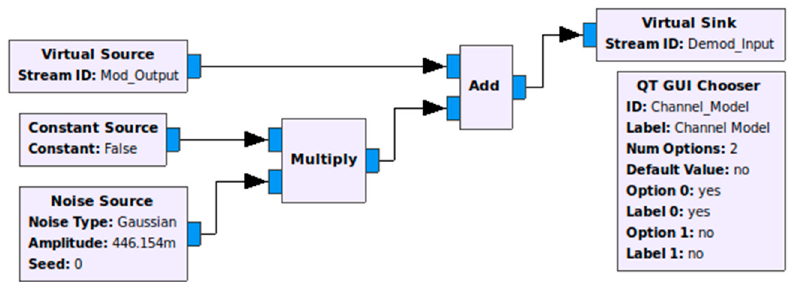
Figure 10. Adding white noise to the signal.